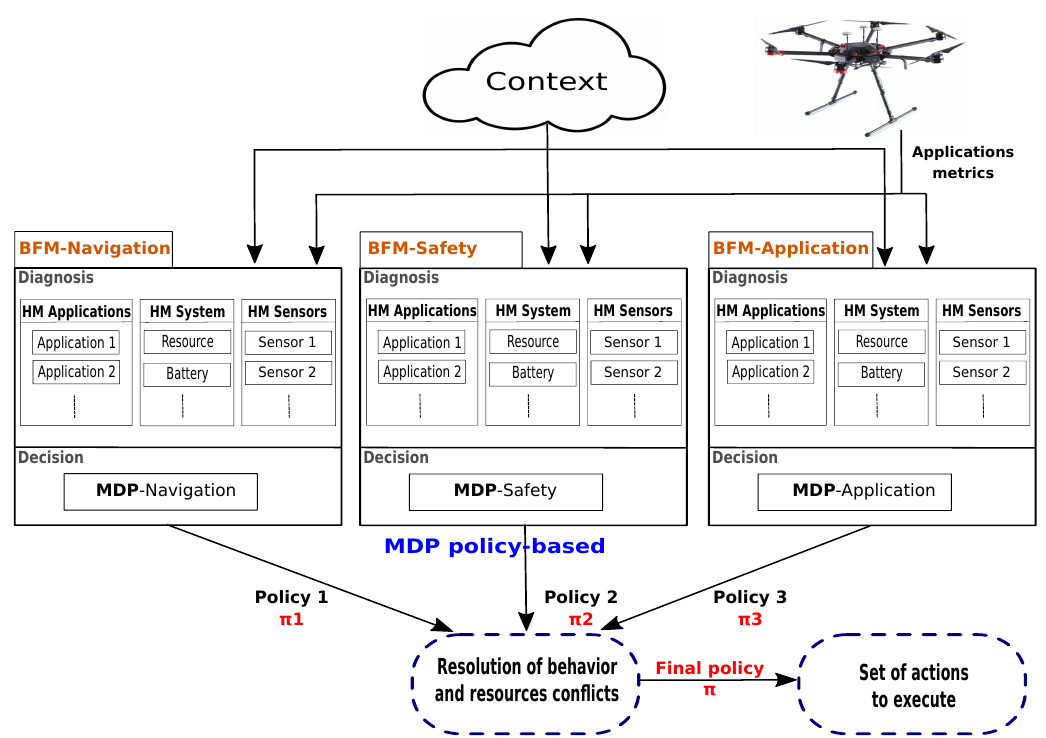
Figure 17. Concurrent MDPs for the